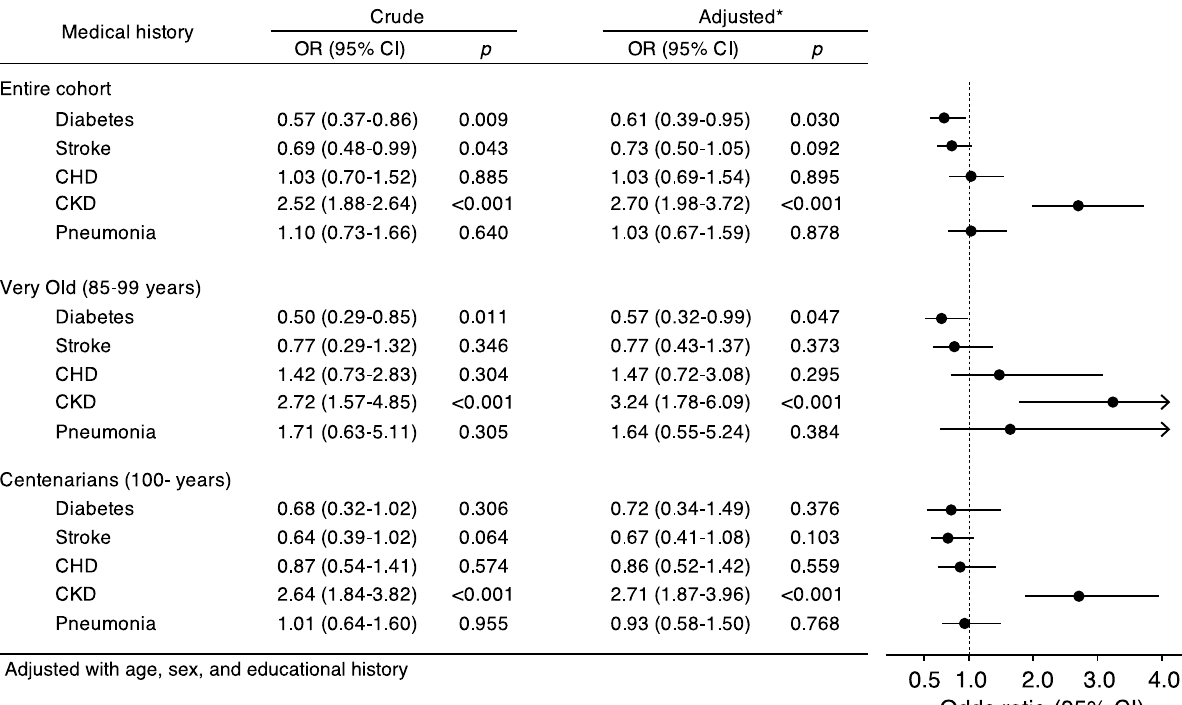
Figure 4. Odds ratios for medical history among top and bottom half groups of plasma EC-SOD concentration in SOD3 p.R231G non-carriers in the Very Old and Centenarians. Total number of SOD3 p.R231G non-carriers in Very Old and Centenarians was 453 and 549, respectively. The results in the “Crude” column indicate the results analyzed using the generalized linear model without adjustment factor and the results in the “Adjusted” column indicate the results analyzed using the generalized linear model adjusted with age, sex, and educational history. The black circles and lines in the figure indicate the odds ratio (OR) and range for 95% confidence interval (CI) in the “Adjusted” results, respectively. These results suggest that plasma EC-SOD concentration in the SOD3 p.R231G variant non-carriers is associated with a high odds ratio for CKD in both the Very Old and Centenarians, while higher plasma EC-SOD concentration is only associated with low odds ratio for DM only in the Very